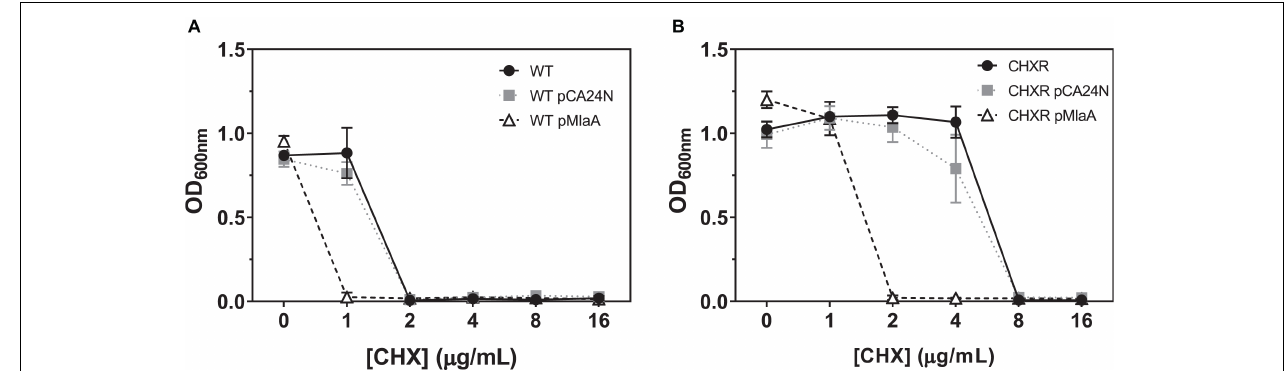
FIGURE 6 | A summary of broth microdilution AST OD 600 nm values for CHXR and WT pCA24N and pMlaA transformants after 18 h of growth at 37 ◦ C. (A) pCA24N, and pMlaA transformed CHXR1-3 isolates OD 600 nm values after 18 h of growth at 37 ◦ C at increasing CHX concentrations. The results of CHXR1-3 isolate OD 600 nm values are shown as a plotted average and error bars indicate standard deviation. (B) pCA24N, and pMlaA transformed WT (BW25113) isolates OD 600 nm values after 18 h of growth at 37 ◦ C at increasing CHX concentrations with chloramphenicol selection. Untransformed CHXR1-3 isolate (A) or WT (B) OD 600 nm values are shown in each panel as a negative control reference and were grown in the absence of chloramphenicol. All transformant AST OD 600 nm values were measured in biological triplicate.